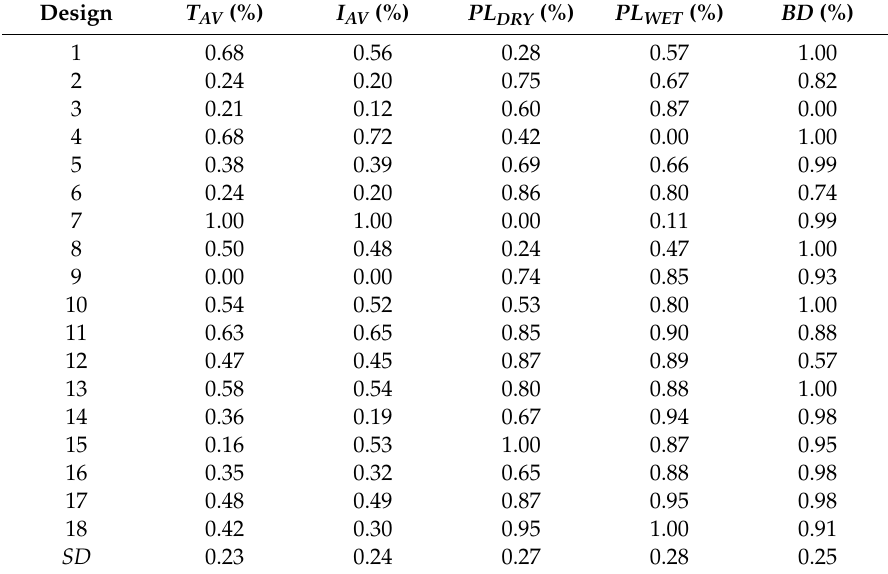
Table 8. Normalized decision matrix for the CRITIC method.